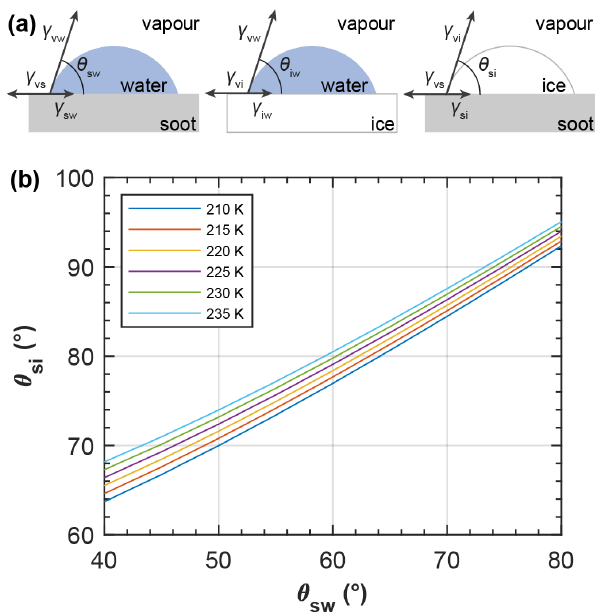
Figure C1. (a) Illustration of the contact angles of water on soot ( θ sw ), water on ice ( θ iw ), and ice on soot ( θ si ). (b) Soot–ice con- tact angle as a function of the soot–water contact angle for different temperatures, as indicated in the legend, calculated using Eq.